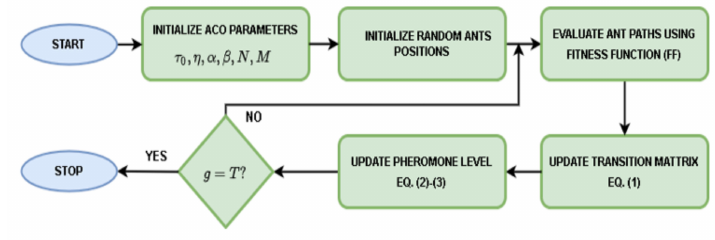
Figure 1. Flow diagram of the